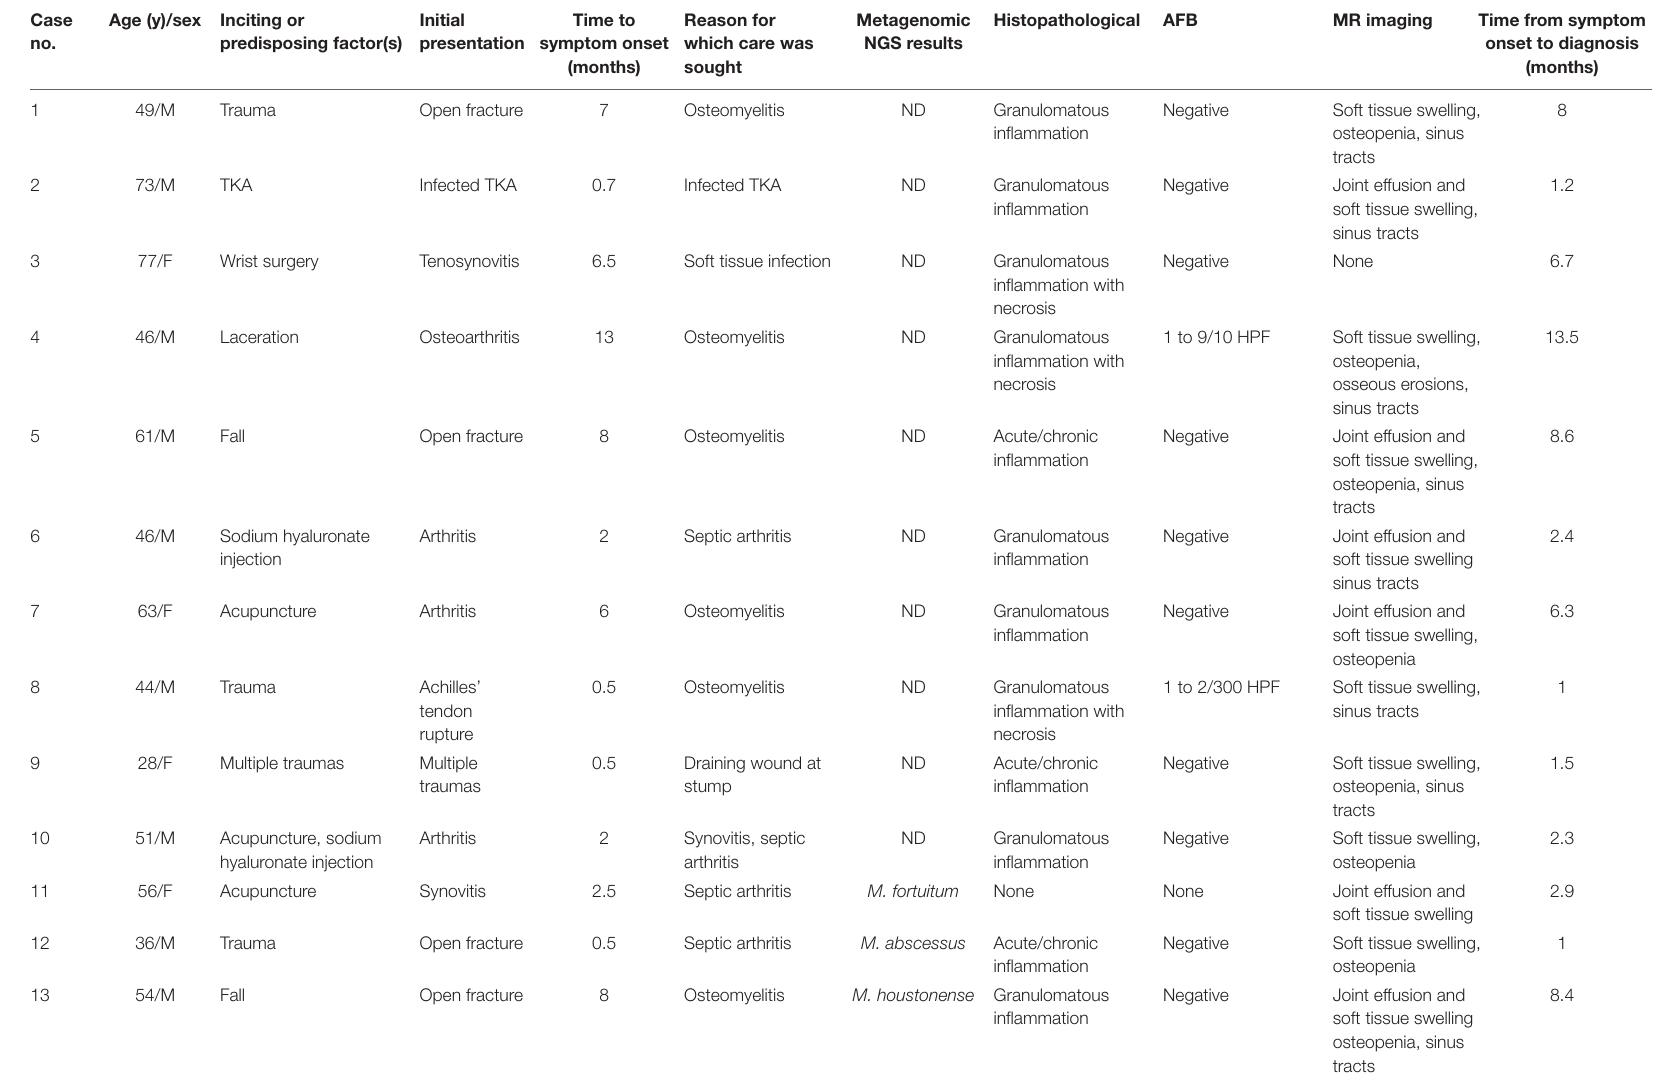
TABLE 1 | Clinical manifestations and correlated findings of 25 patients with musculoskeletal non-tuberculous mycobacterial infections in Henan, China. Case